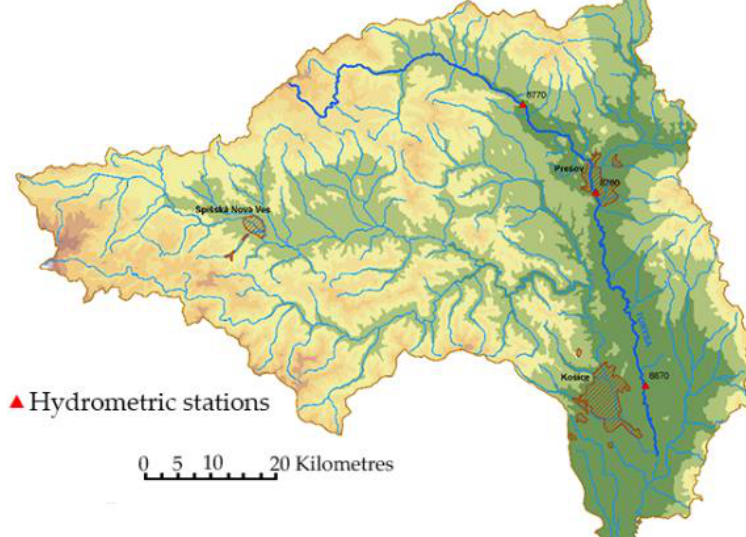
Figure 3. Location of the watercourse and representation of altitude data from the DEM model for the selected area of the watercourse Torysa.